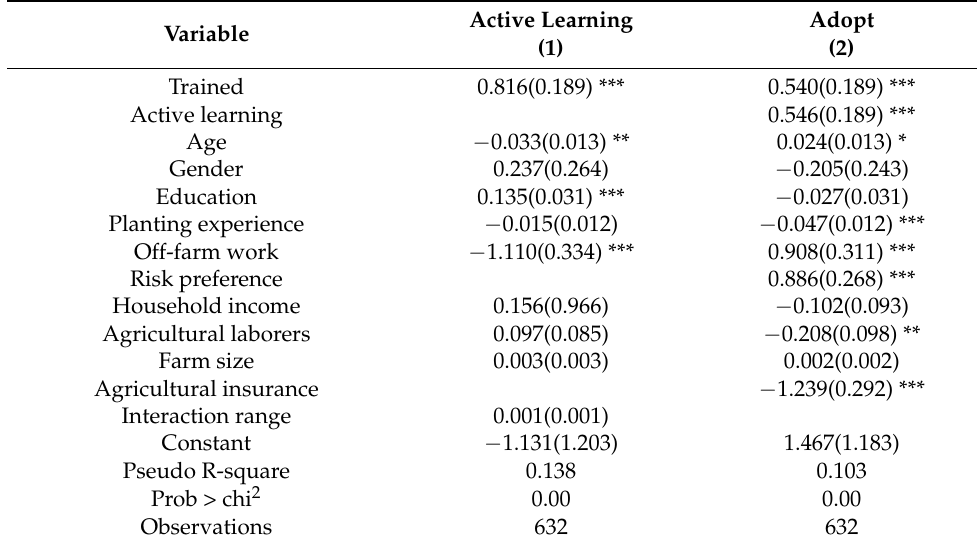
Table 8. The mediating effect of farmers’ active